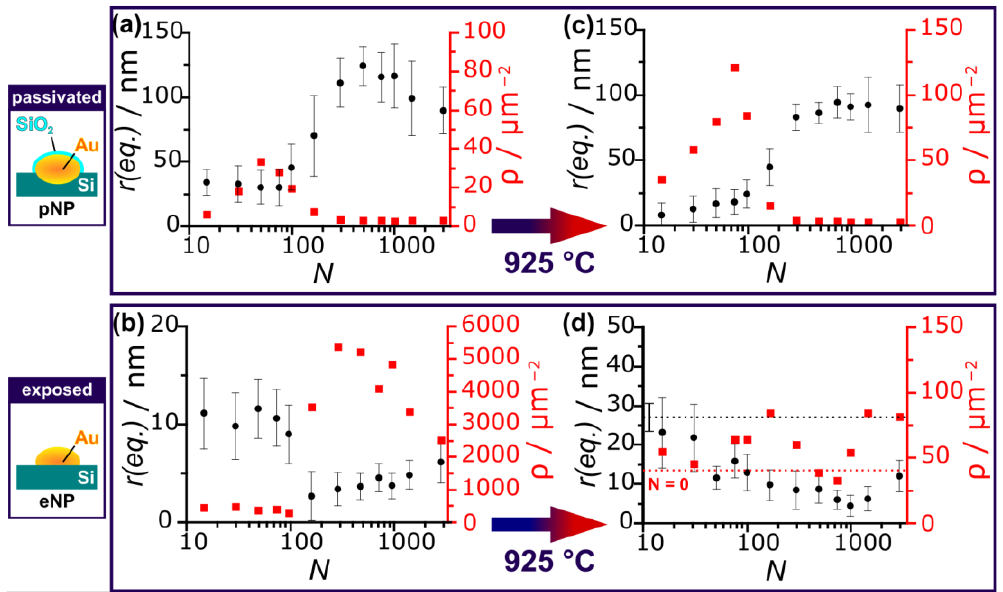
Figure 5. Equivalent radius r(eq.) (black) and area particle density ρ (red) of gold nanoparticles after laser irradiation ( a , b ) and after a subsequent heating process at a substrate temperature T = 925 °C ( c , d ) for both, passivated (pNPs, a , c ) and exposed (eNPs, b , d ) gold nanoparticles. The dashed lines represent the value for Au particles generated by the heating induced dewetting on unirradiated samples ( N = 0).